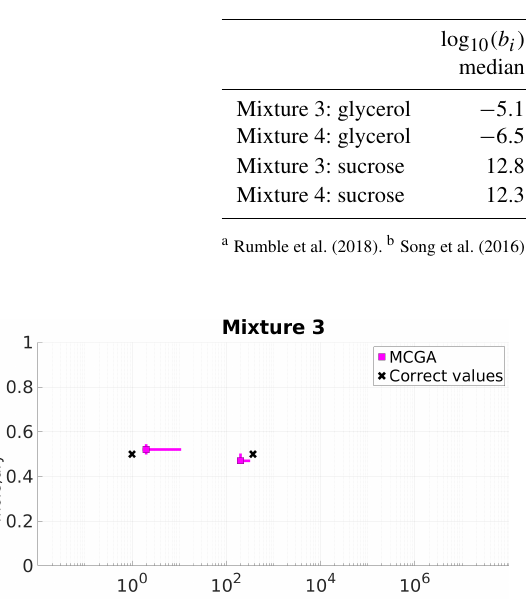
Table 6. The median b parameter which describes the contribution of glycerol and sucrose to the particle viscosity from optimizing the KM-GAP model to match the low RH measurement of mixtures 3 and 4. The literature values for viscosity of glycerol are also reported. For sucrose the reported literature value is an experimental fit calculated from viscosity measurements of sucrose–water mixtures evaluated at RH = 0%.